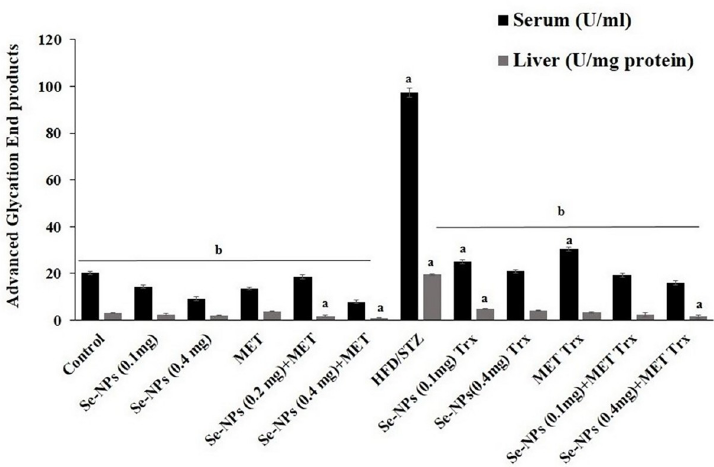
Fig 5. Effect of Se-NPs and MET on AGEs levels of serum and liver tissues in HFD/STZ-induced rats. Values are mean ± SE ( n = 10). Significant changes (p < 0.01) with respect to control and HFD/STZ-experimental rats are expressed by the letters (a) and (b),